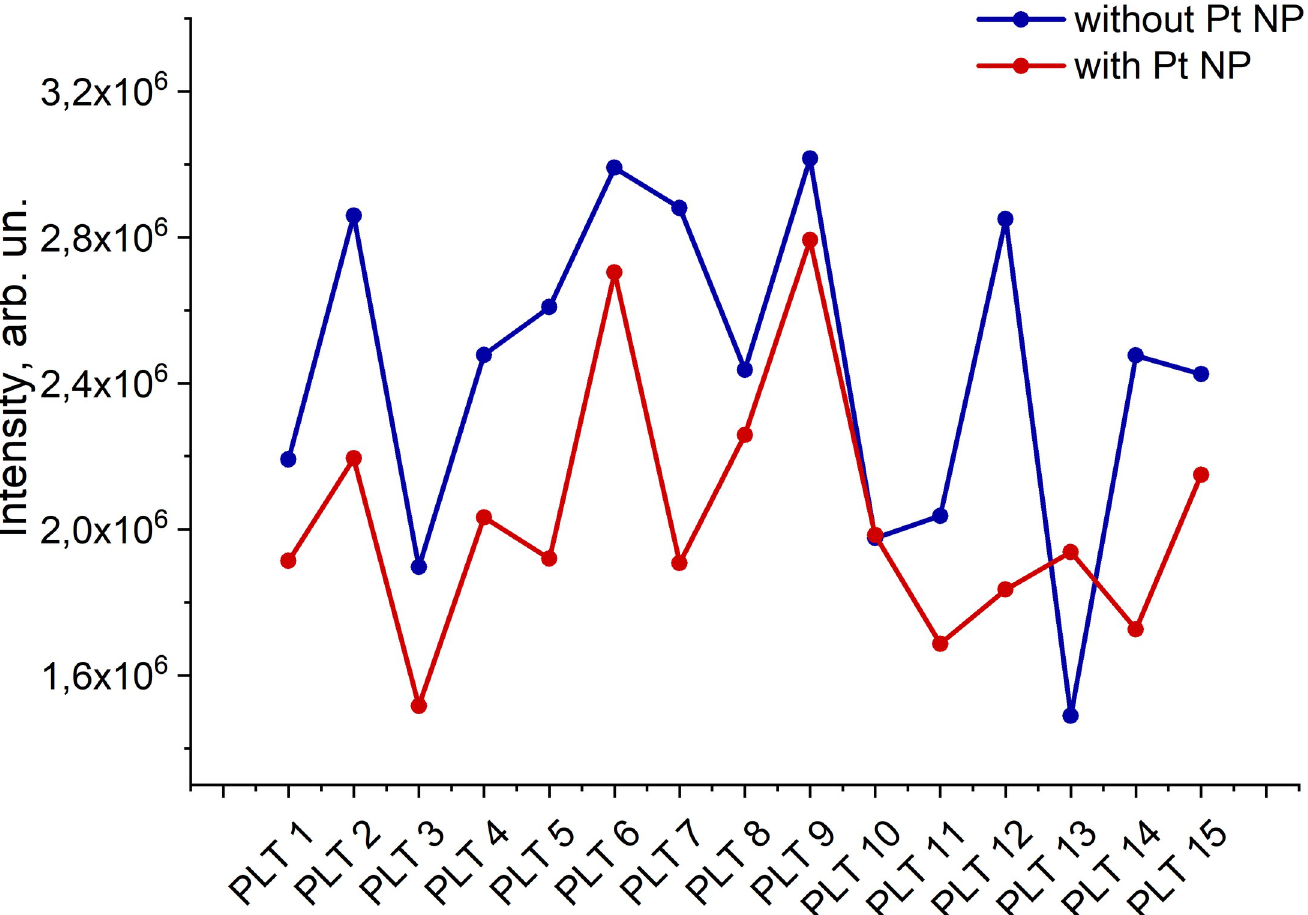
Fig 9. Fluorescence intensity of platelets without (blue line) and with (red line) Pt